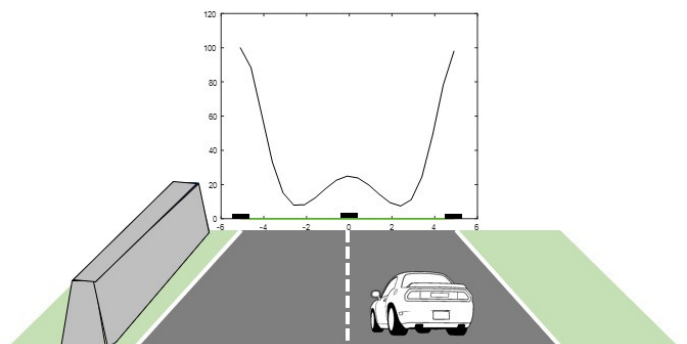
Figure 10. Obstacle-dependent Gaussian (ODG) for solid and dotted lines.